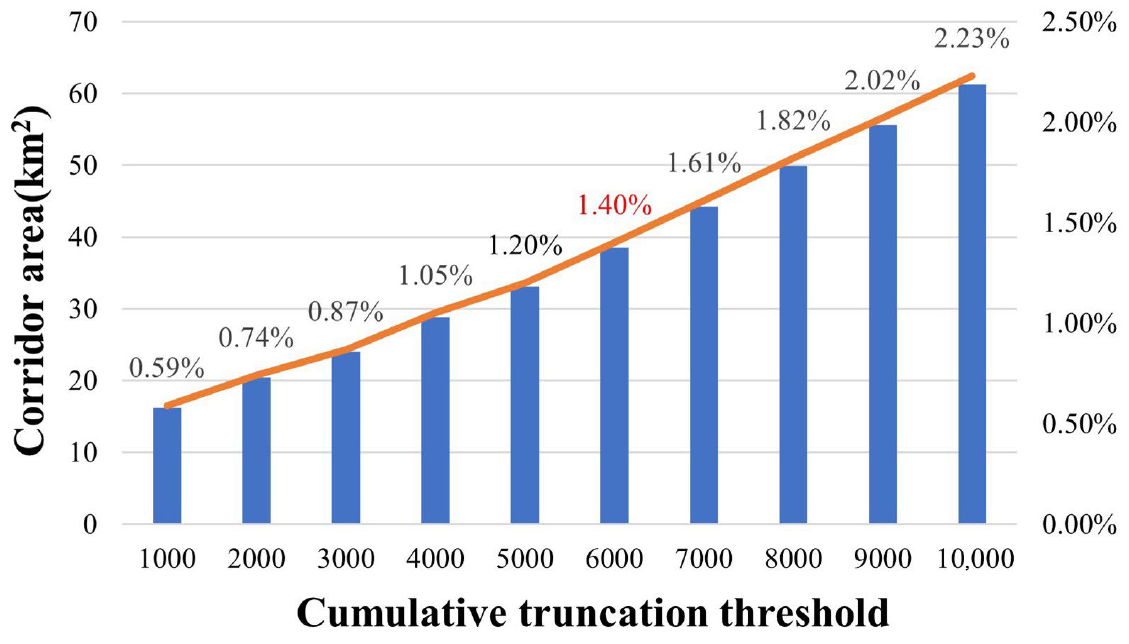
Figure 8. Corridor area under different thresholds.